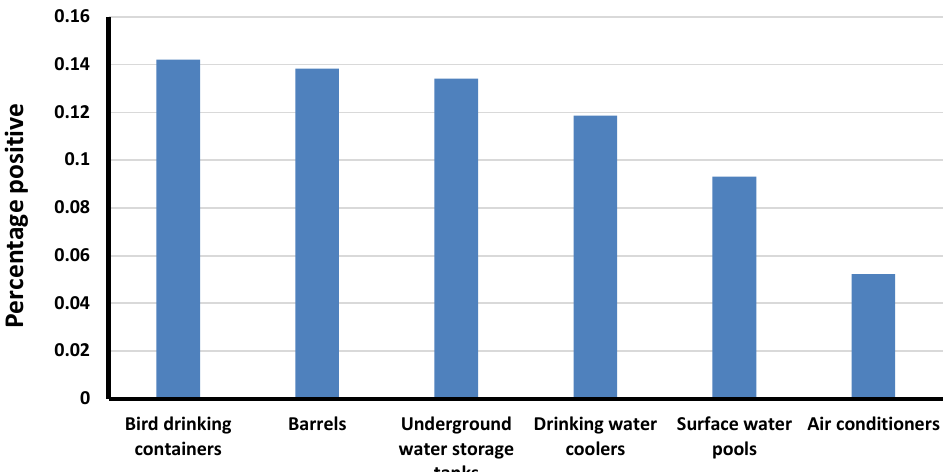
Figure 3. Water sources positive for Aedes aegypti larvae.